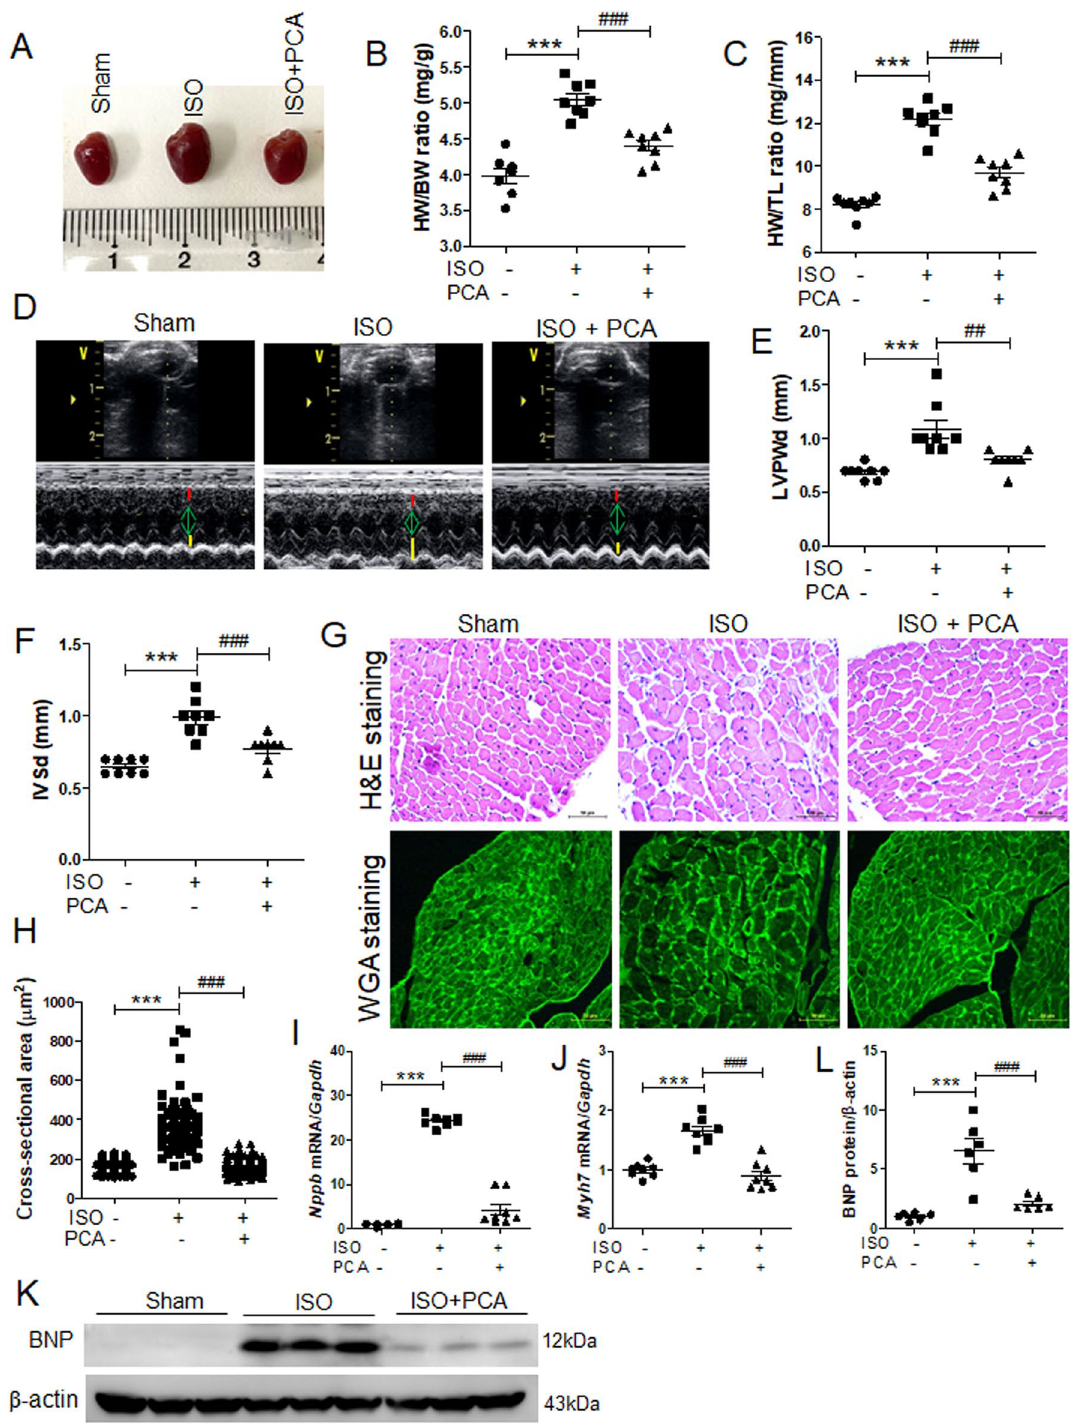
Figure 2. Protocatechuic acid attenuates isoproterenol-induced cardiac hypertrophy in vivo. ( A ) Representative images of gross hearts from sham, isoproterenol, and isoproterenol + protocatechuic acid treated mice. ( B , C ) Heart weight to body weight ratio (HW/ BW) and heart weight to tibia length ratio (HW/TL) of the mice described in ( A ) (n = 8). ***P < 0.001; ### P < 0.001. ( D ) Representative B-mode and M-mode echocardiograms are shown. Cardiac hypertrophy was determined by echocardiography after 5 days of isoproterenol administration. ( E,F ) Left ventricular posterior wall thickness (LVPWd, mm) and interventricular septum thickness (IVSd, mm) in mice (n = 8). ***P < 0.001; ## P < 0.01 and ### P < 0.001. ISO, isoproterenol; PCA, protocatechuic acid. ( G ) Representative images of H&E (upper panel) and wheat germ agglutinin (WGA, lower panel) staining of left ventricle papillary muscle from sham, isoproterenol, and isoproterenol + protocatechuic acid-treated mice. Scale bar = 50 μm. ( H ) Cross-sectional area quantification of H&E-stained hearts described in ( G ), n = 161 cells. ***P < 0.001; ### P < 0.001. ( I , J ) Total RNA was isolated from the hearts of mice (n = 8). mRNA levels of Nppb ( I ) and Myh7 ( J ) were determined by RT-PCR and normalized to Gapdh . ***P < 0.001; ### P < 0.001. ( K , L ) Representative Western blot images of BNP and quantification (n = 6); β-actin was used as a loading control. ***P < 0.001; ### P < 0.001 . Data are presented as the mean ± S.E. Statistical analysis: one-way ANOVA followed by Bonferroni post hoc tests. Graphs were prepared using GraphPad